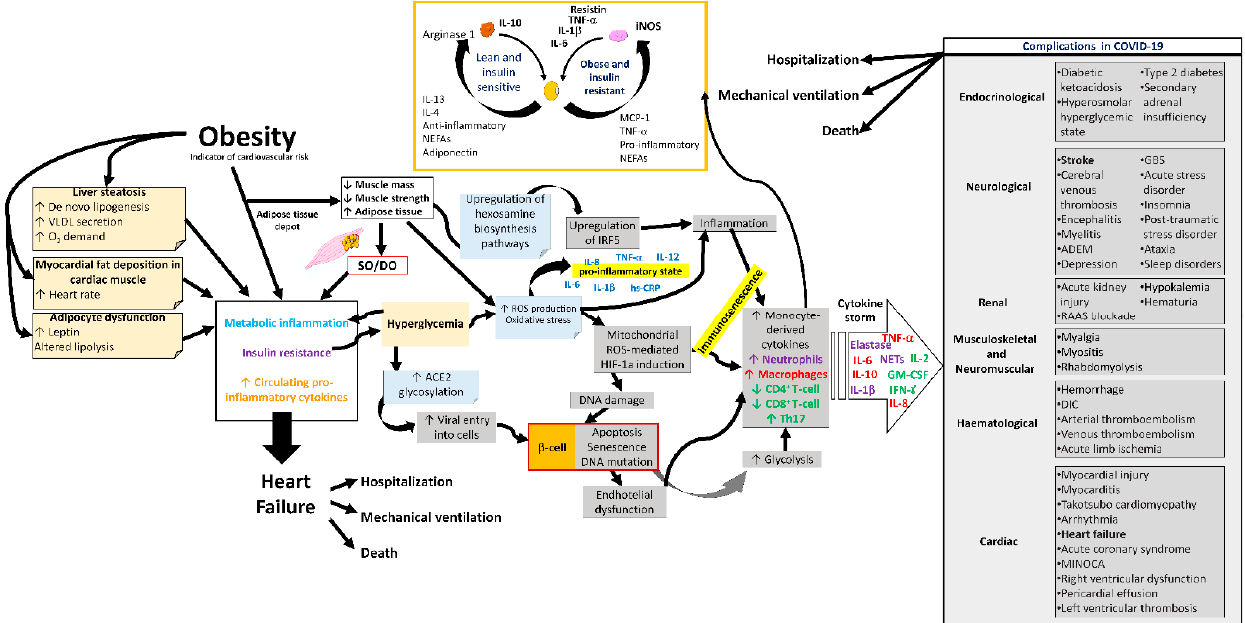
Figure 3. Complications in COVID-19 due to sarcopenic obesity and dynapenic obesity. Alterations in the metabolism, respiratory system, cardiovascular system, and immune system of the SO and/or DO patient with a propensity for complications during COVID-19. SO, sarcopenic obesity; DO, dynapenic obesity; ROS, reactive oxygen species; hs-CRP, high-sensitivity C-reactive protein; ACE2, angiotensin-converting enzyme 2; NETs, neutrophil extracellular traps; GM-CSF, granulocyte macrophage colony-stimulating factor; IFN- γ , gamma interferon; HIF-1a, hypoxia-inducible factor-1 α ; IRF5, interferon regulatory factor 5; VLDL, very low-density lipoprotein; ADEM, acute disseminated encephalomyelitis; GBS, Guillain–Barré syndrome; RAAS, renin–angiotensin–aldosterone system; DIC, disseminated intravascular coagulation; MINOCA, myocardial infarction with nonobstructive coronaries.